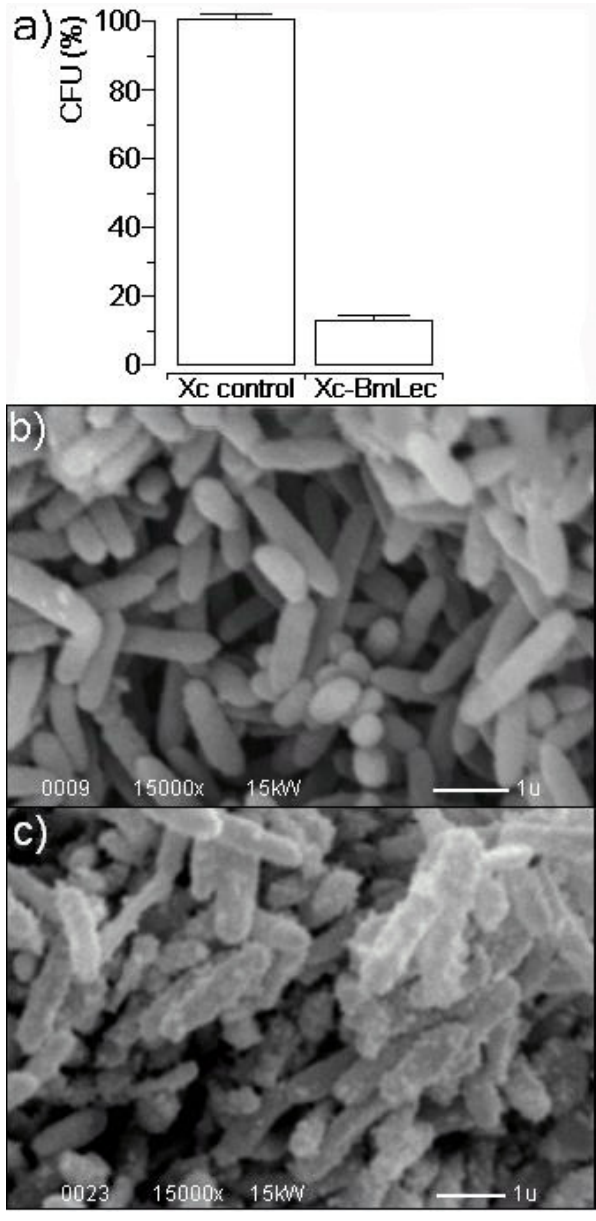
Figure 7. ( a ) The antibacterial activity of BmLec. ( b ) Morphology of Xanthomonas axonopodis pv. passiflorae (Xc) control without lectin. (c) Ultrastructural alterations of Xc induced by